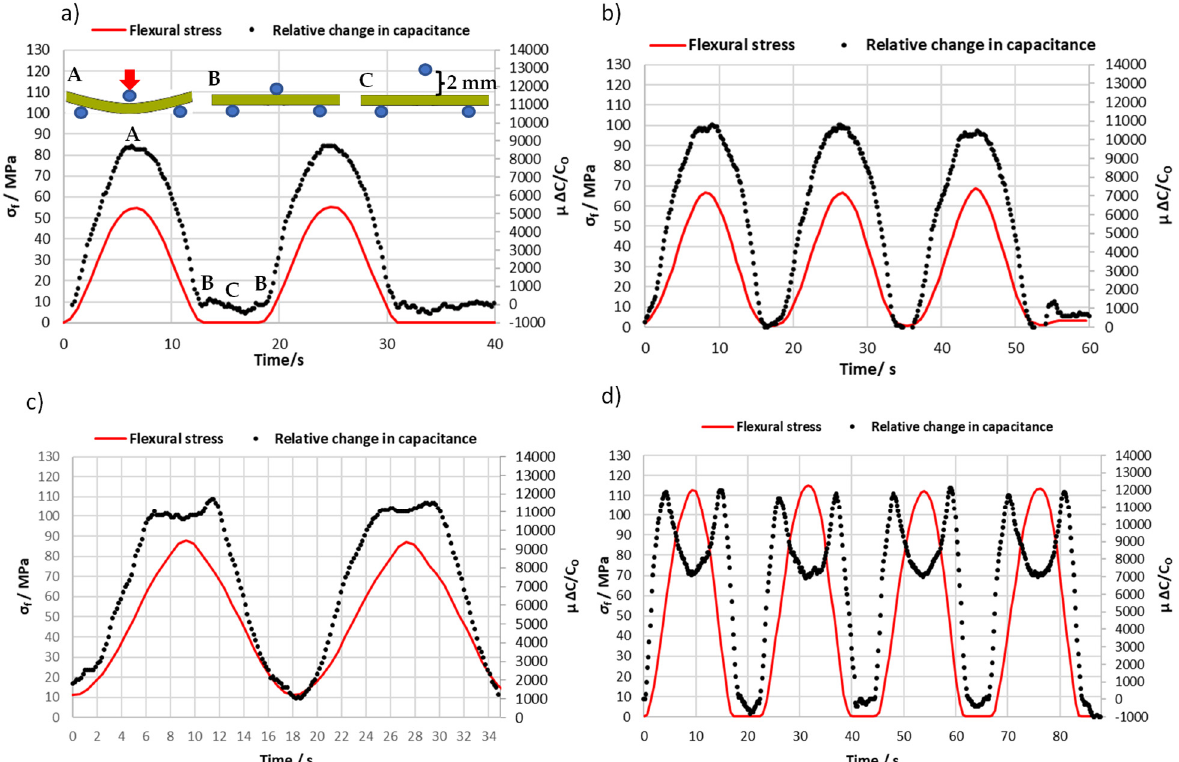
13 of 21 Table 4. Electrical and mechanical results obtained from three-point bending test for type-B speci- mens. R* is the ratio of the maximum flexural stress to the flexural strength of GFRP (460 MPa). Maximum Flexural Stress/MPa Stress Ra- tio/R* Approximated Deflection ( δ )/mm Loading Fre- quency/mHz Turning Point Charac- teristics Flexural